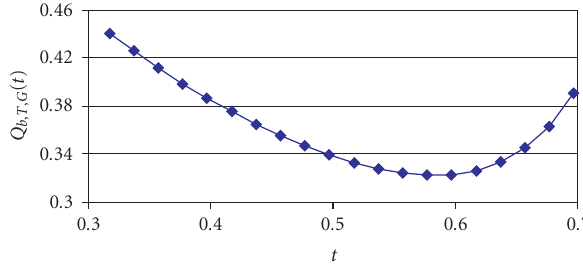
Figure 4: Inverse perceptual quality curve for Example